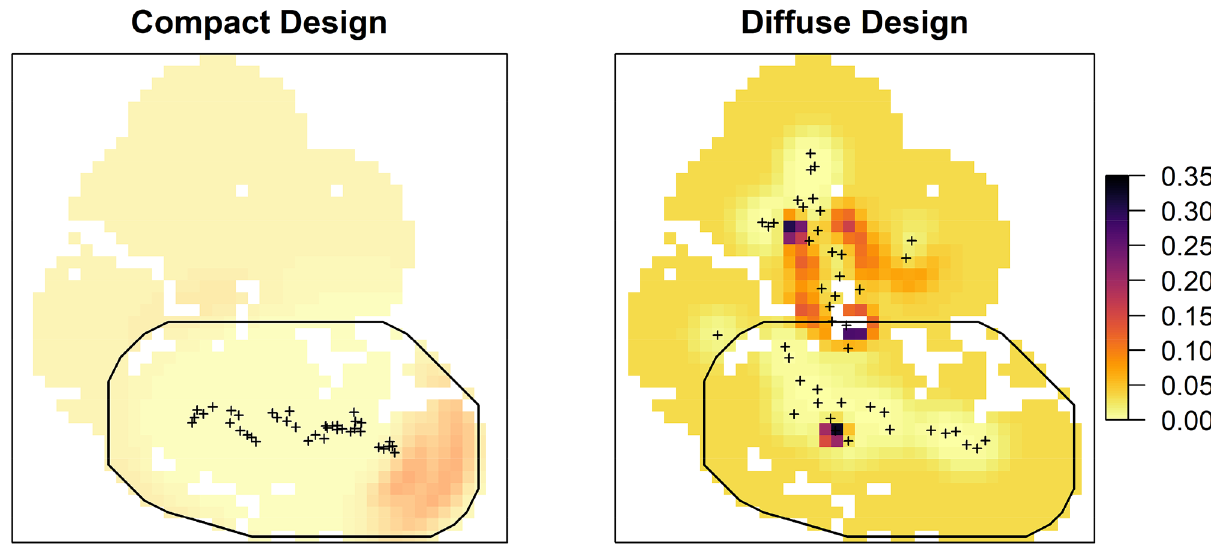
Figure 3. Spatial pattern of snow leopard density (animals/100 km 2 ) in Hunza-Nagar districts, Gilgit-Baltistan, Pakistan. Plus sign represents trap locations. Black polygon marks area of compact